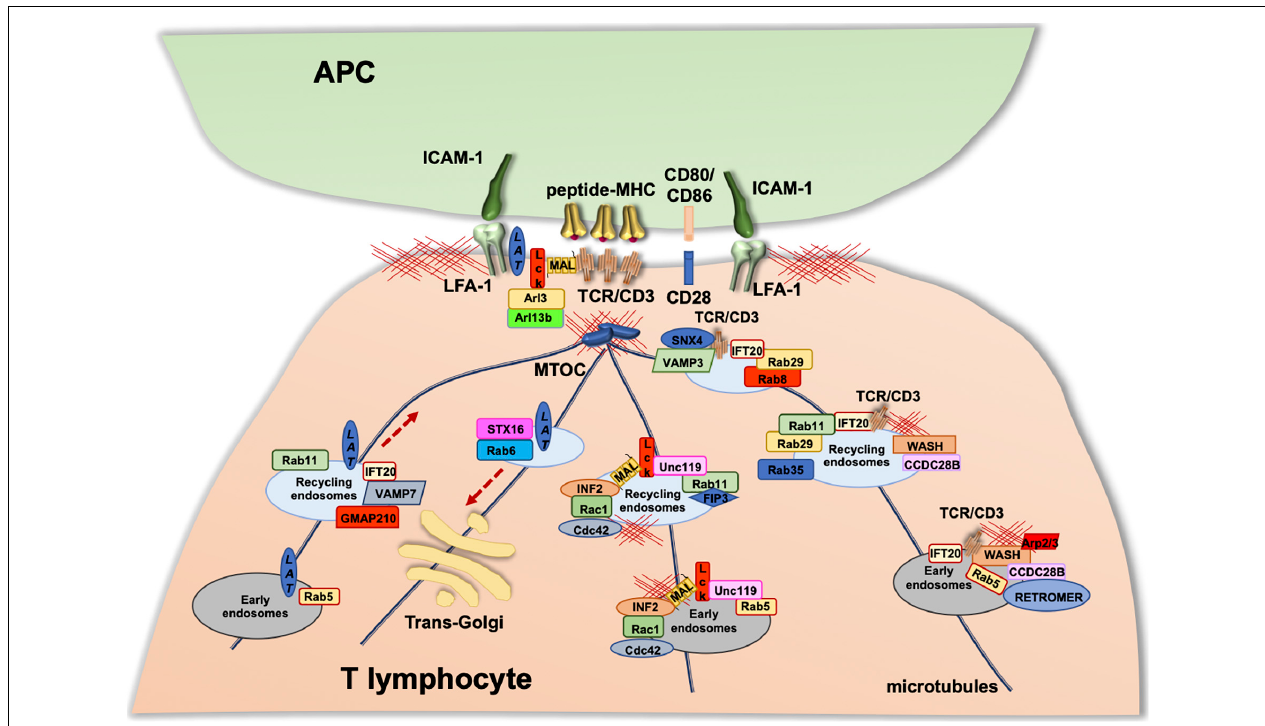
FIGURE 3 | Vesicular trafficking in the regulation of IS formation. Upon TCR stimulation, the T-cell receptor, as well as associated signaling molecules (e.g., LAT and Lck), are delivered to the IS via endosomal vesicles. The polarized trafficking of different molecules occurs through distinct trafficking routes within the “classical” recycling pathway regulated by the Rab5 and Rab11. TCR-polarized trafficking to the IS involves additional Rab GTPases, some components of the intraflagellar transport (IFT) system, and the ciliogenesis protein CCDC28B that is essential for WAS-dependent actin polymerization on TCR + endosomes. Lck associates with Rab11 + endosomal compartments, and its transport to the IS and sorting to the cSMAC are regulated by the uncoordinated 119 protein (Unc119), the membrane protein MAL, and Rab11-FIP3. LAT trafficking to the IS occurs through the classical Rab5 and Rab11 route, where anterograde transport is specifically regulated by GMAP210, IFT20, and VAMP7 and retrograde transport by Rab6 and